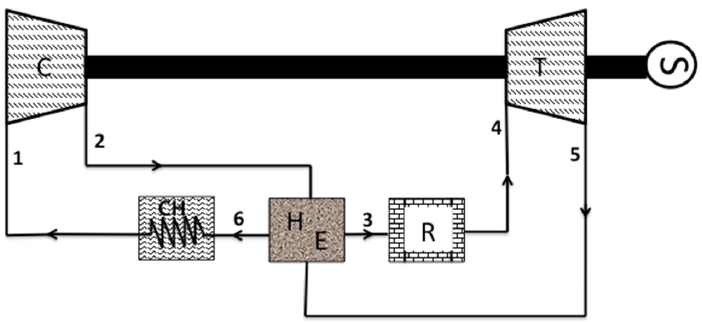
Figure 1. Typical Simple Cycle Recuperated (SCR) [7]. Single shaft spool connection to the turbomachinery which includes a precooler, reactor, and recuperator. The schematic shows 6 stations.